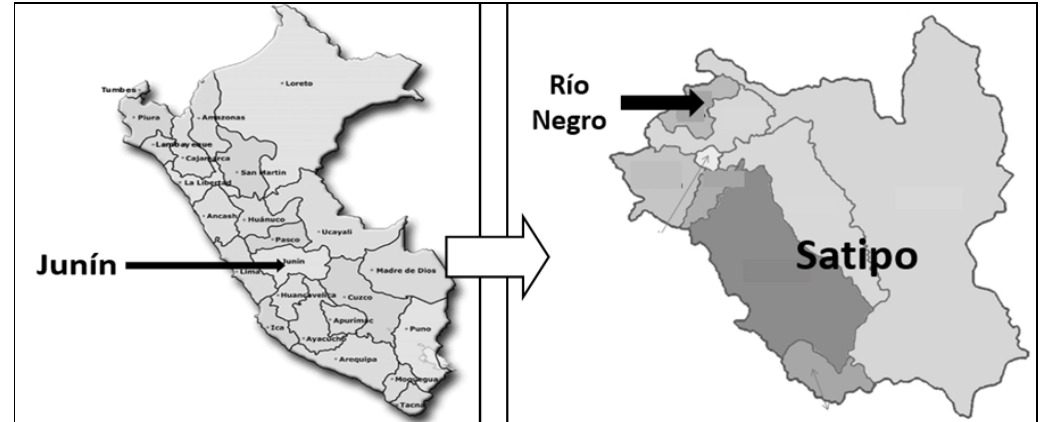
Figure 1. Location of the district of Río Negro in the province of Satipo in the department of Junín, Peru.